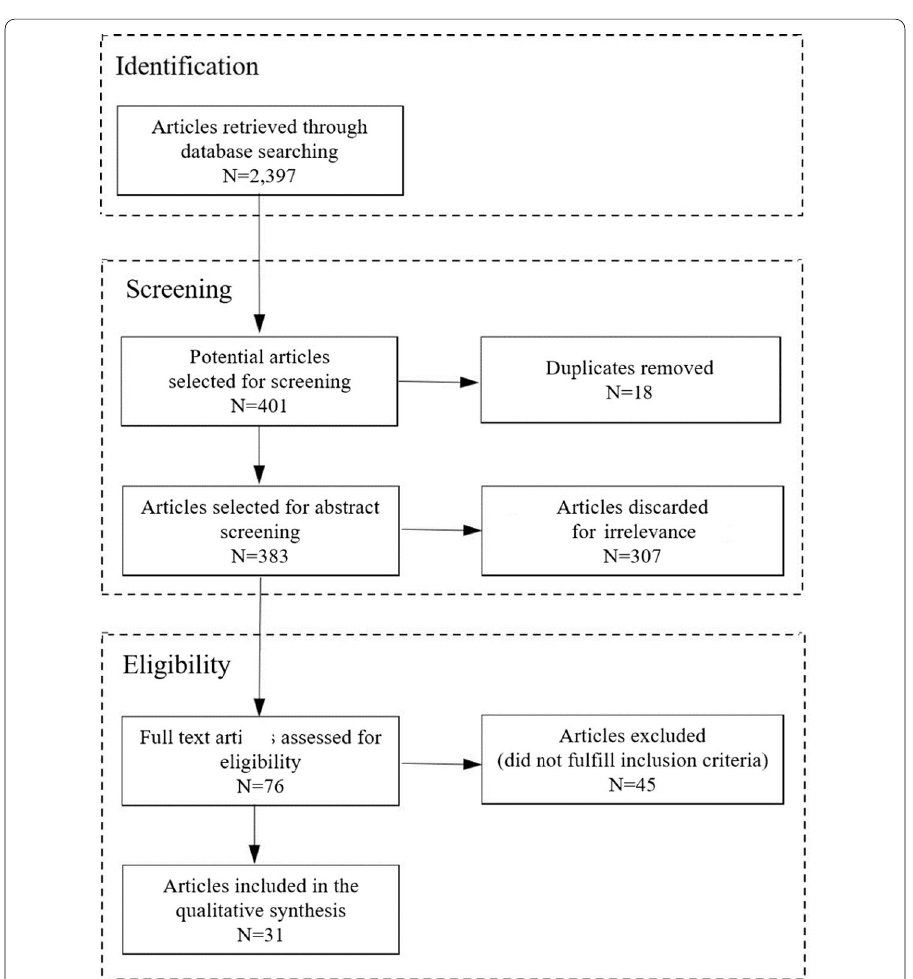
Fig. 1 Flow diagram of the article selection